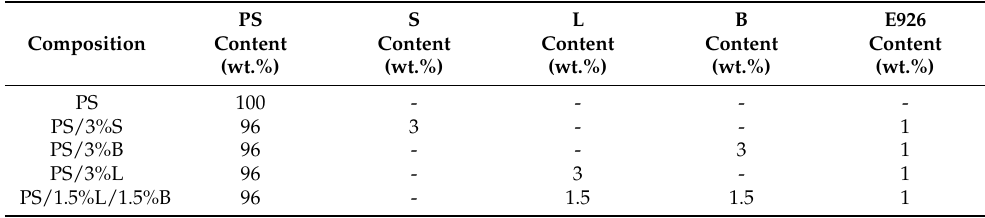
Table 1. Compositional data of the